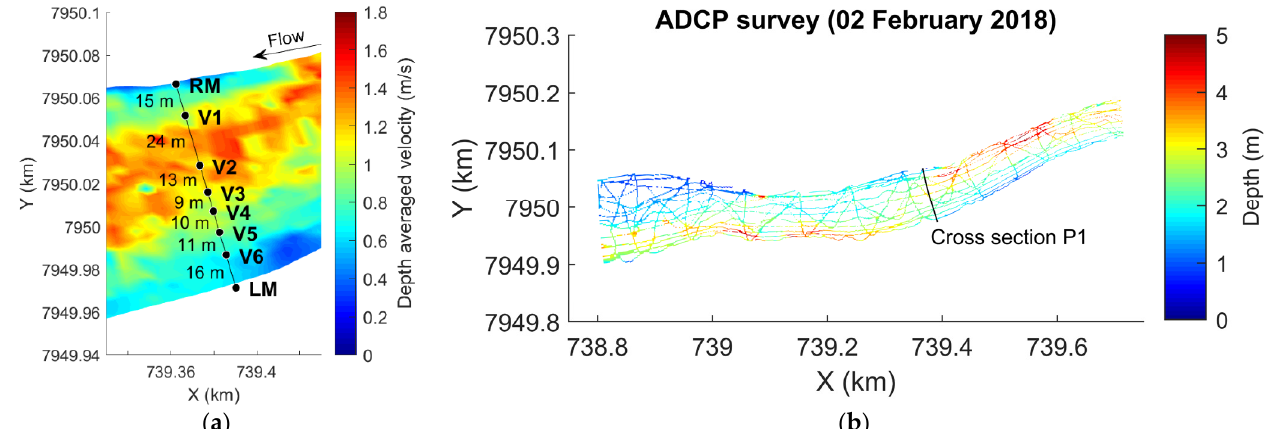
Figure 2. ( a ) Cross-section P1 and verticals of static measurements; ( b ) depth points measured during the ADCP bathymetric survey. Flow occurs from right to left.